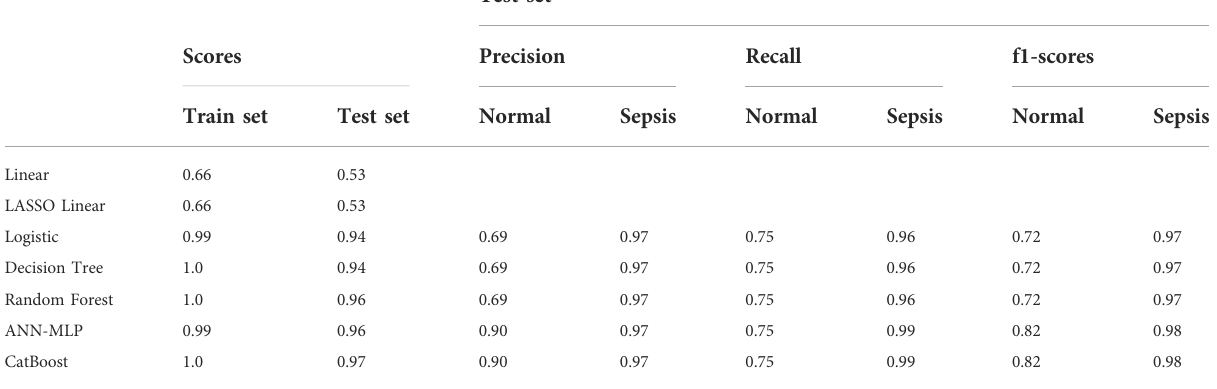
TABLE 1 Methods used for models and the classi fi cation report of the test